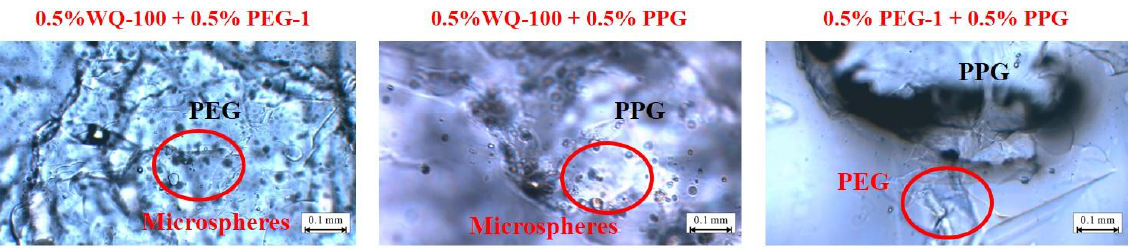
Figure 8. Pre-crosslinking gel particle absorptive effect.